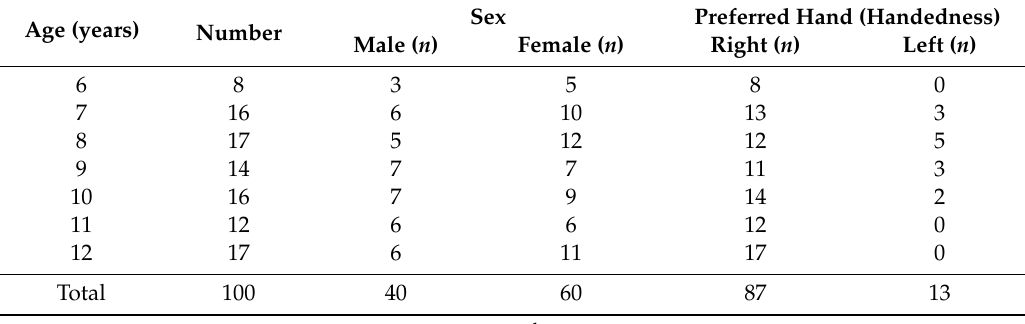
Table 1. Distributions of age, sex, and preferred hand of the entire